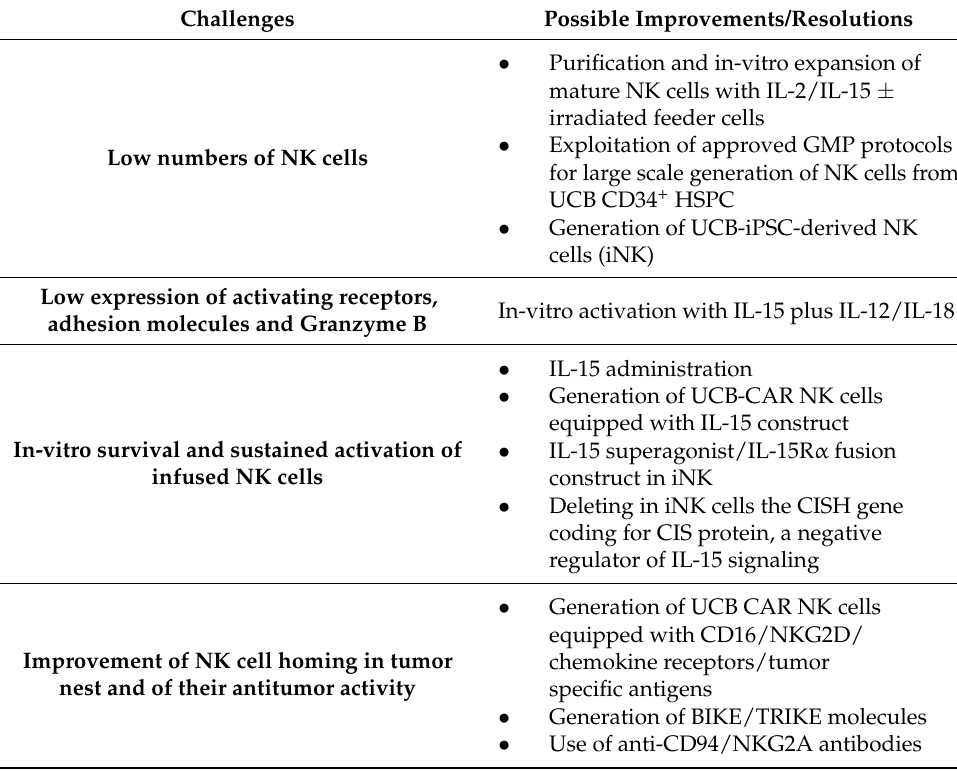
Table 1. The challenge of designing UCB-derived NK cell adoptive